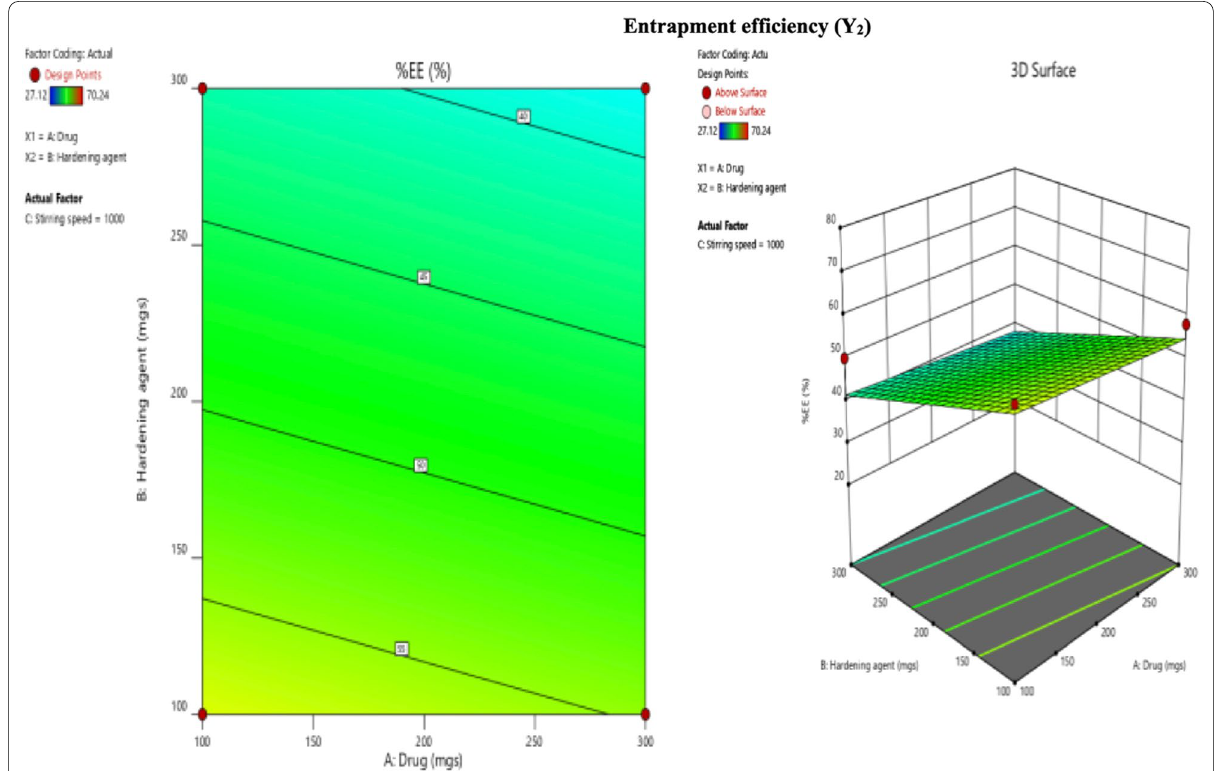
Fig. 2 Contour plot and response surface plot for entrapment efficiency ( Y 2 ) optimized